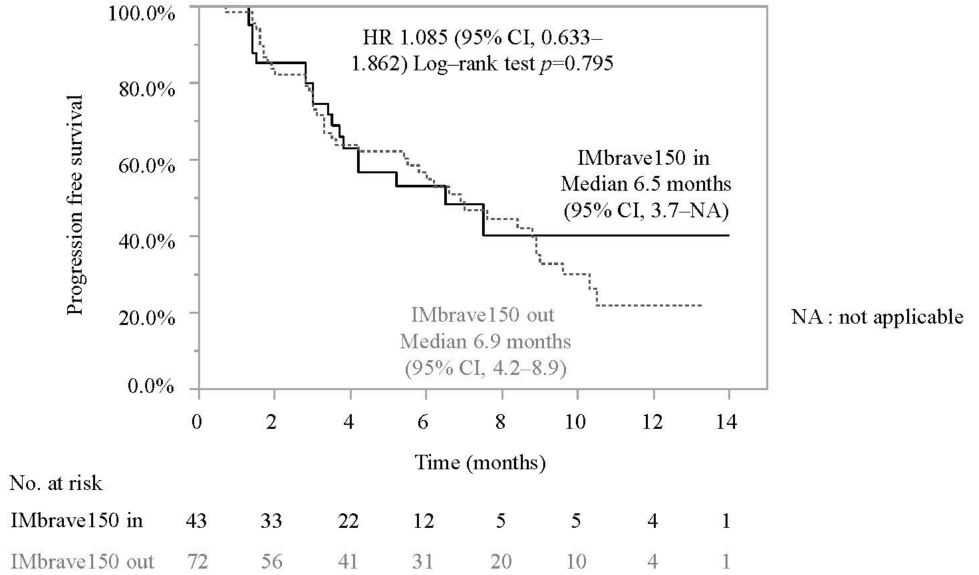
Figure 1. Progression-free survival in patients with unresectable HCC who were treated with atezolizumab and bevacizumab. Median progression-free survival was 6.6 months (95% confidence interval 5.2–8.9 months). 95% CI: 95% confidence interval.